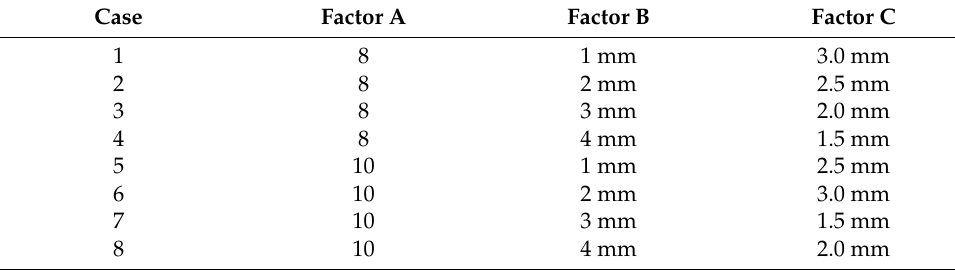
Table 5. Test groups of the orthogonal